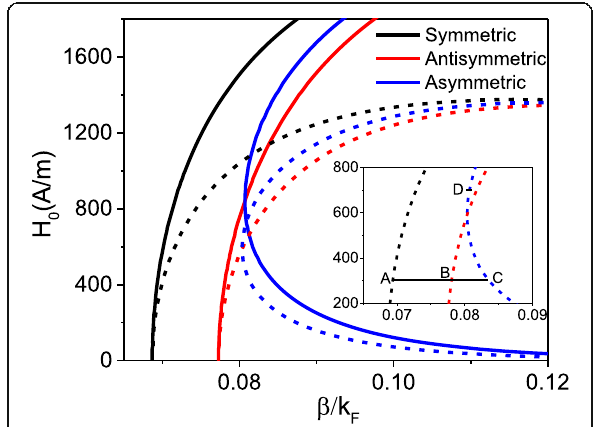
Fig. 2 The initial magnetic intensity versus the propagation constant. For the solid curves : α = 5 × 10 − 16 ( m / v ) 2 , σ NL = 0; for the dashed curves : α = 5 × 10 − 16 ( m / v ) 2 , σ NL = 2.19 × 10 − 20 i, the horizontal black solid line is an auxiliary